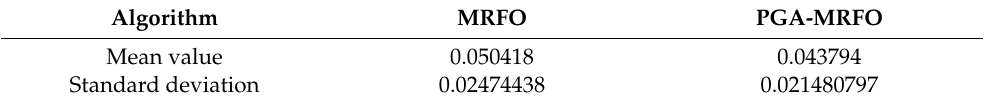
Table 11. The mean and standard deviations of the calculated time for algorithms based on 50